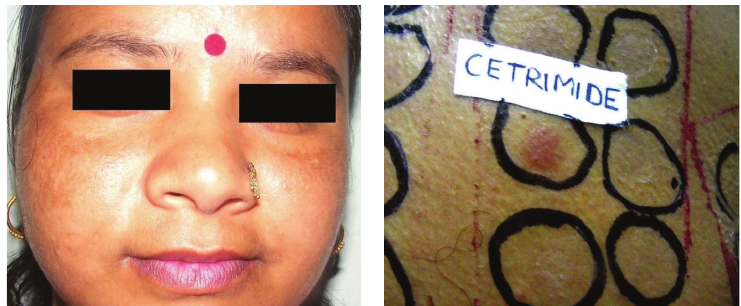
Figure 3: A patient with malar pattern of melasma and positive patch test from cetrimide.